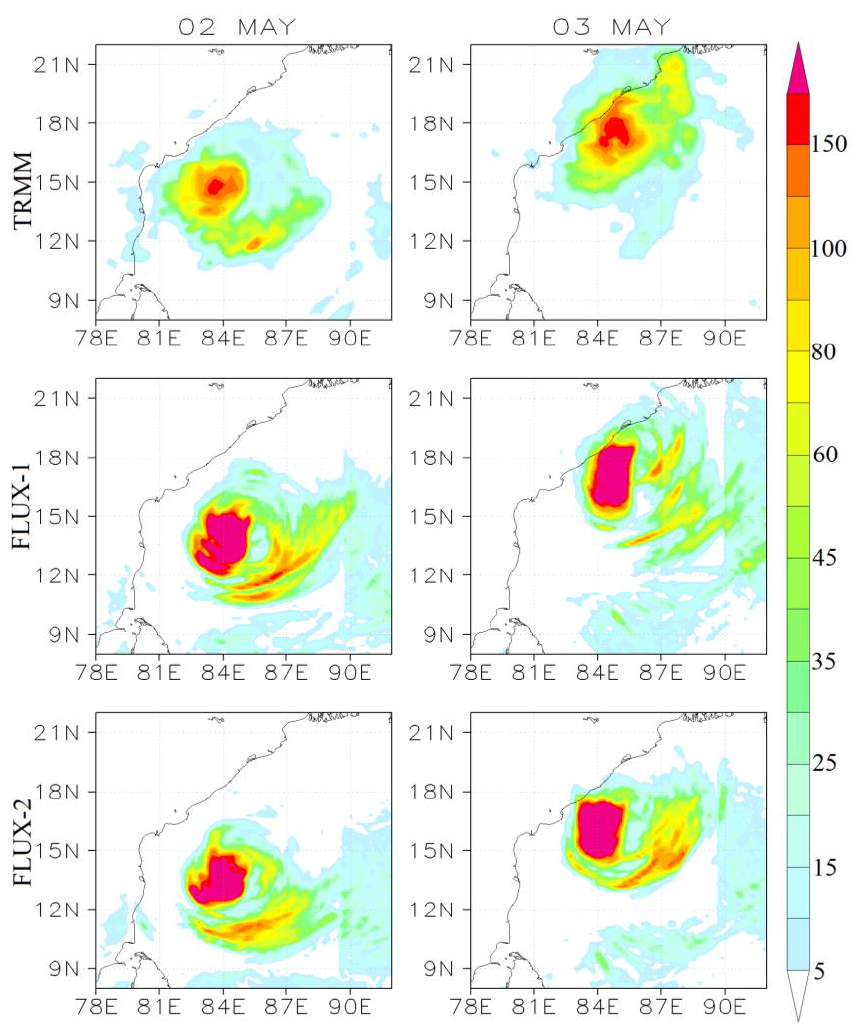
Figure 12. Daily rainfall (in mm) on 2 May and 3 May 2019 from TRMM and model forecast.